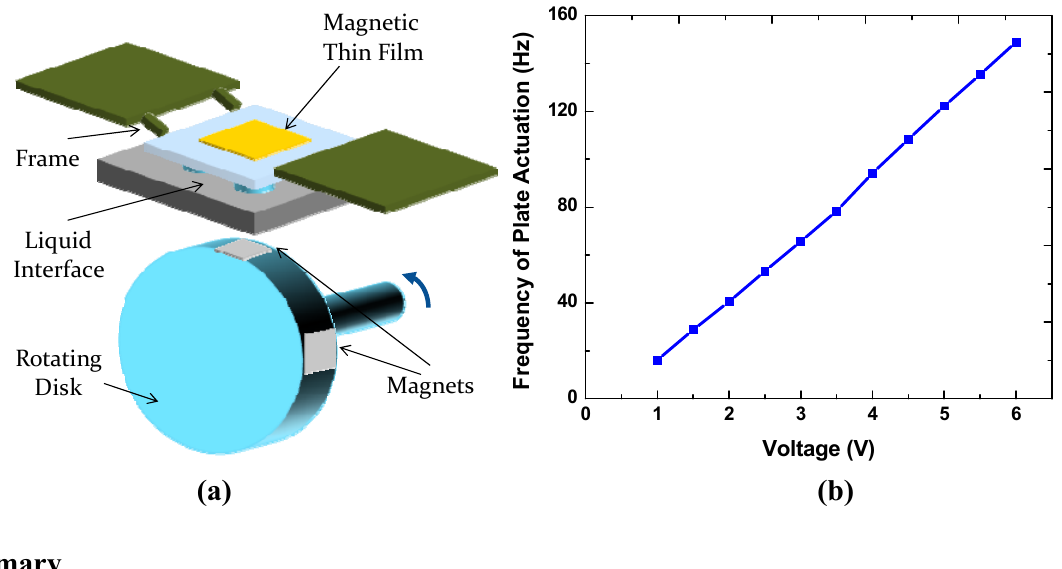
Figure 10. ( a ) Schematic of the life testing setup; ( b ) Plate actuation frequency as a function of voltage applied to the DC